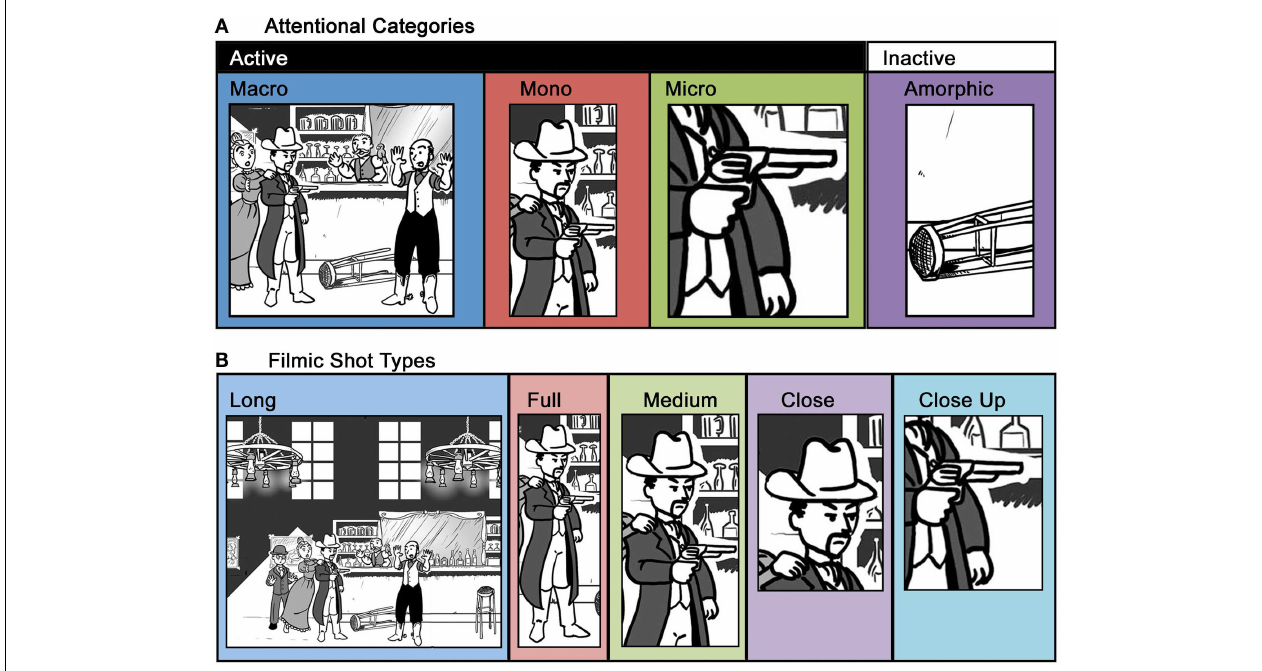
FIGURE 1 |A single scene framed by attentional categories (A) and filmic shot type (B). Attentional categories outline the meaningful elements of a scene, while filmic shot types present those meaningful elements in different